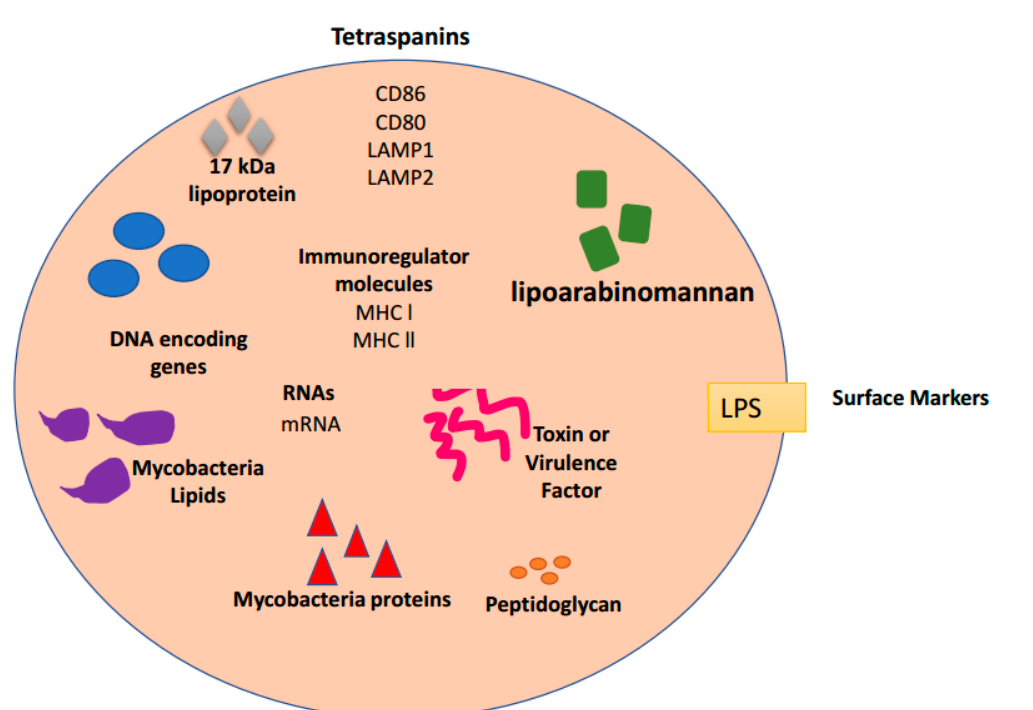
Figure 3. Composition of bacteria-derived exosomes. Proteomic, Biochemical, and Immunological investigations have identified many specific proteins and RNAs present in some exosomes. This is a limited representation of common molecules present within some bacteria-derived